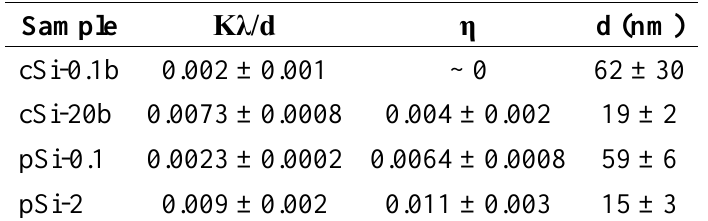
Table 3. Crystallites size obtained by means of Williamson-Hall plot.